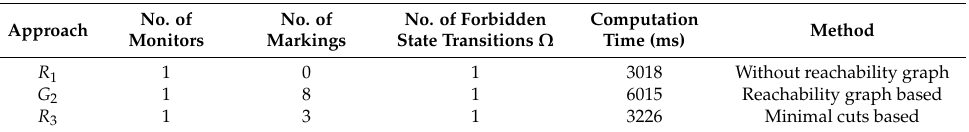
Table 13. Comparison results of case study 1.